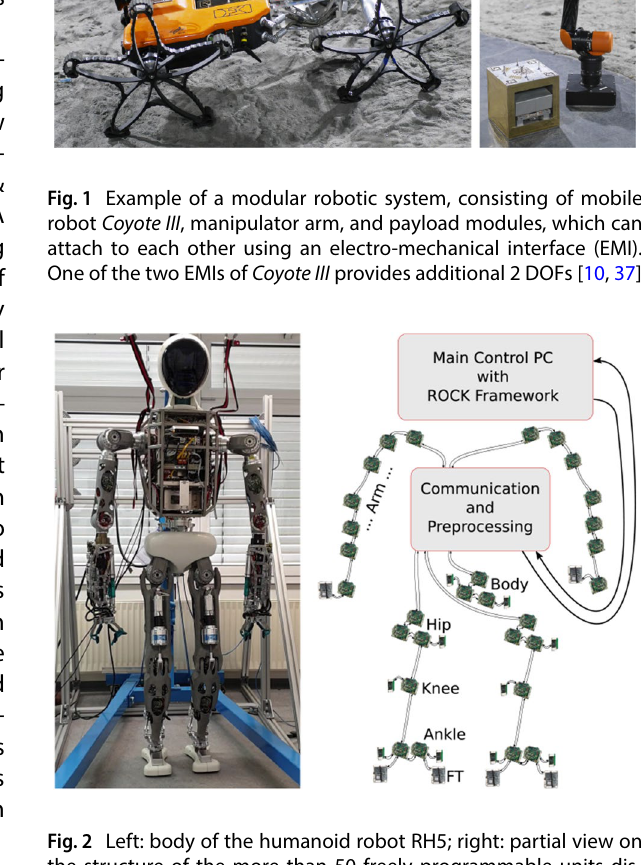
Fig. 2 Left: body of the humanoid robot RH5; right: partial view on the structure of the more than 50 freely programmable units dis- tributed across the